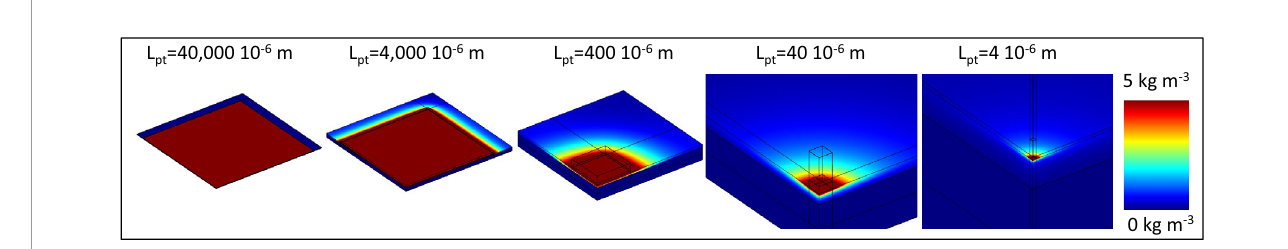
FIGURE 15 | Color contours of drug concentration over the skin for different sizes of the reservoir for simulations with an in fi nite reservoir after 72 h, so when a steady-state is reached. Note that the maximal range is not depicted (80 kg m -3 ), and only one-fourth of the patch-skin system shown due